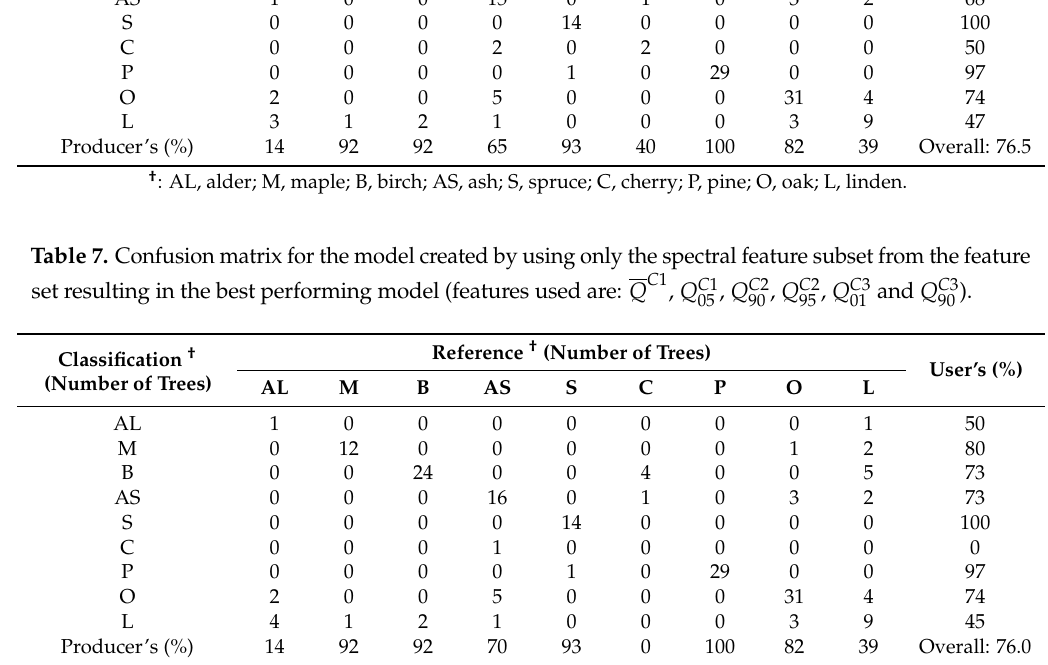
C 1 , Q , Q C 1 , Q C 1 , Q C 2 , 90 05 50 90